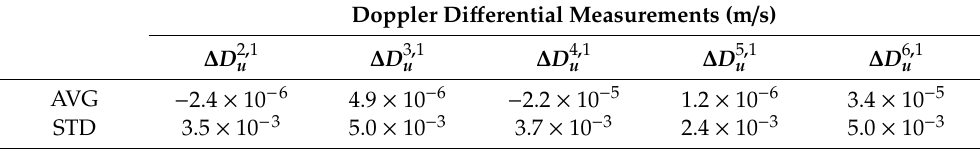
Figure 5. Positioning results using the Doppler differential positioning algorithm in the static test.